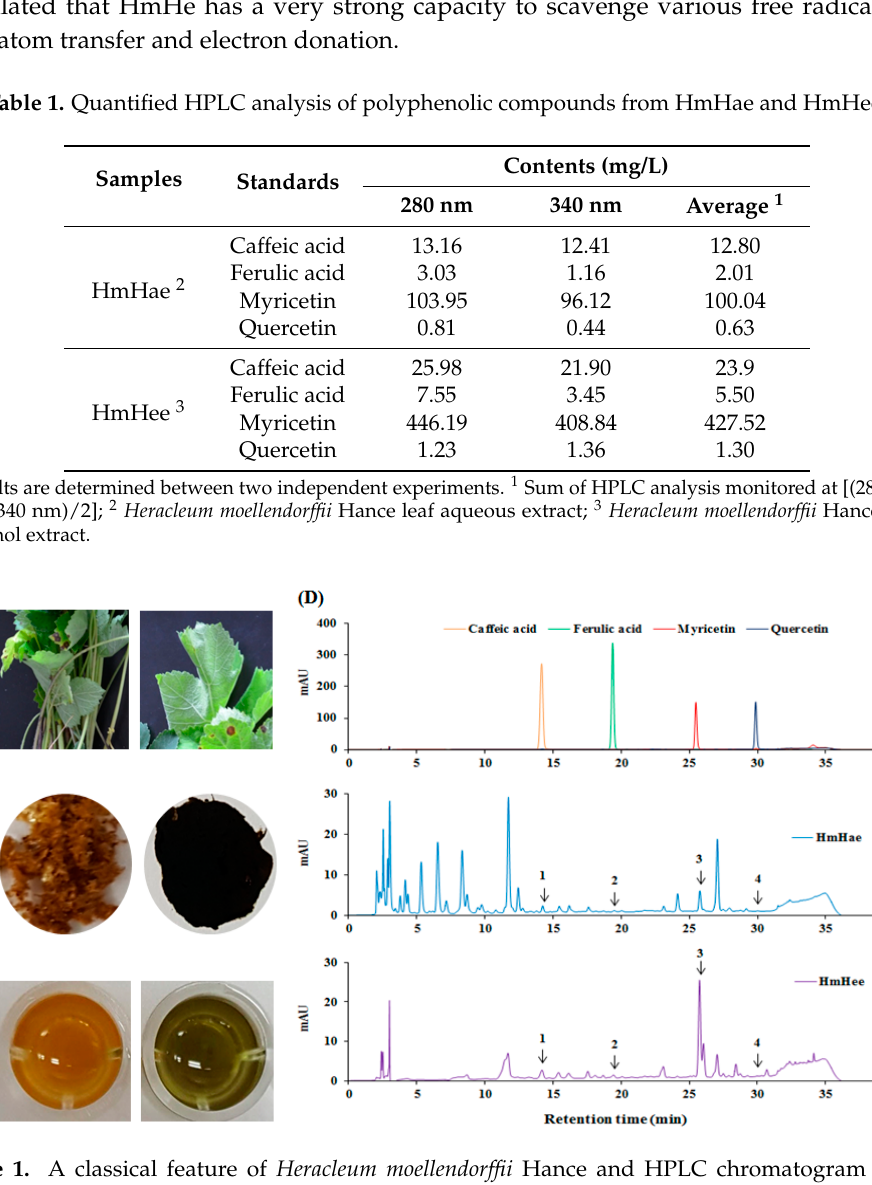
Table 1. Quantified HPLC analysis of polyphenolic compounds from HmHae and HmHee. Samples